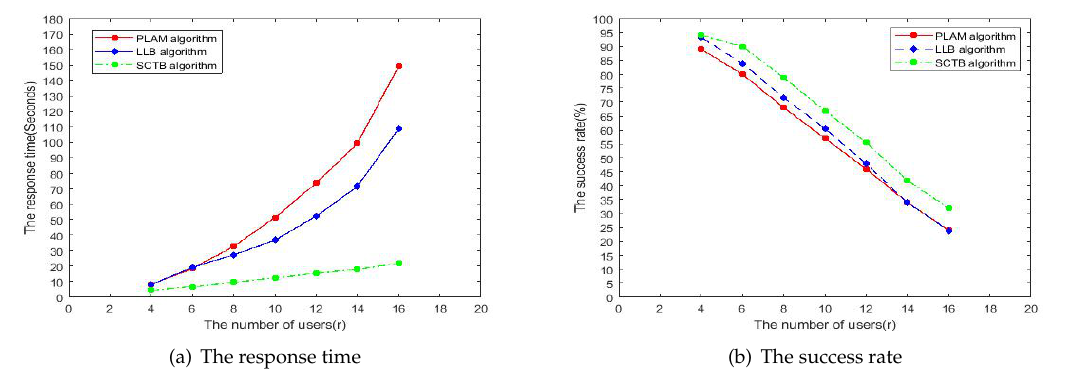
Figure 12. The simulation results for Scenario-2.